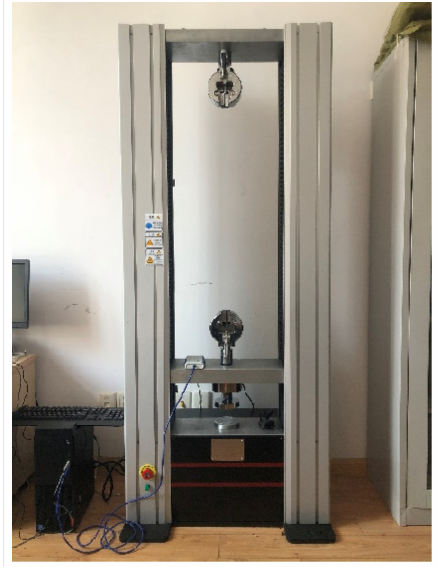
Figure 2. MIT-20 testing